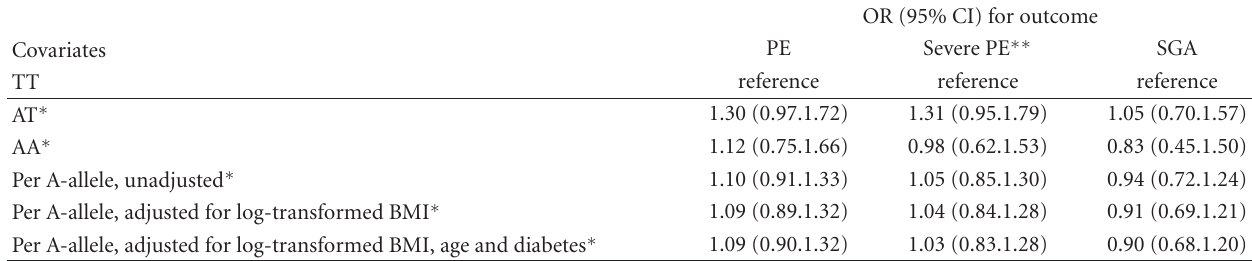
Table 3: The odds ratios (95% CI) for preeclampsia (PE). Severe PE and small-for-gestational age (SGA) associated with maternal FTO SNP rs9939609 AA and AT genotypes as well as with each additional A allele (unadjusted and adjusted) in a Finnish study population. OR (95% CI) for